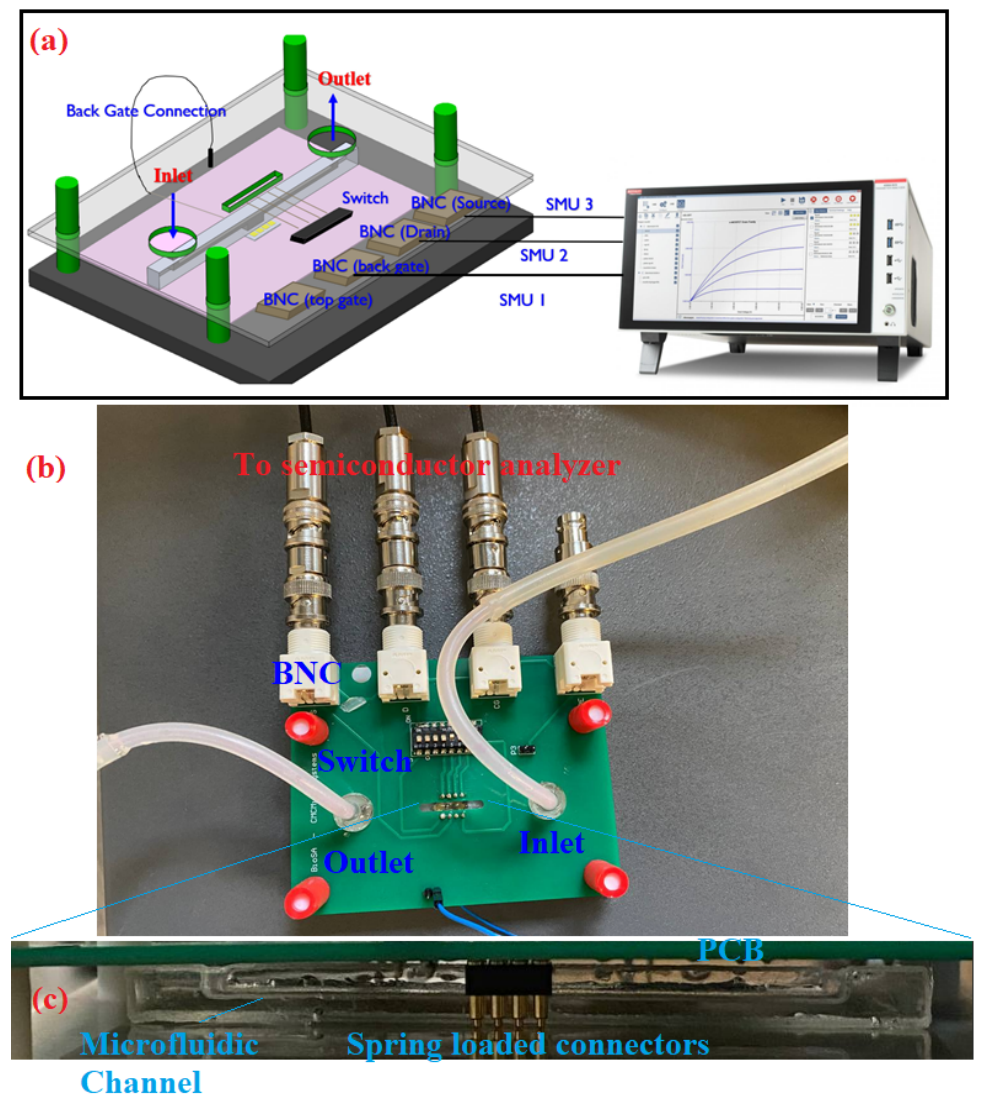
Figure 7. The experiment setup was used to test the OG ‐ JFET sensor. ( a ): shows the CAD design of the fixture used for connecting the sensor to the semiconductor analyzer. ( b ): the fabricated test setup, consisting of PCB (BNC, switch), 3D printed support and microfluidic with its tubing. The back gate was contacted from the back of the sensor to top on the PCB, where it was connected to a BNC connector to the semiconductor analyzer. ( c ): shows the spring ‐ loaded connectors used to connect the OG ‐ JFET pads to the PCB. On the PCB, there is a switch that enables the user to select the specific channel on the OG ‐ JFET sensor.